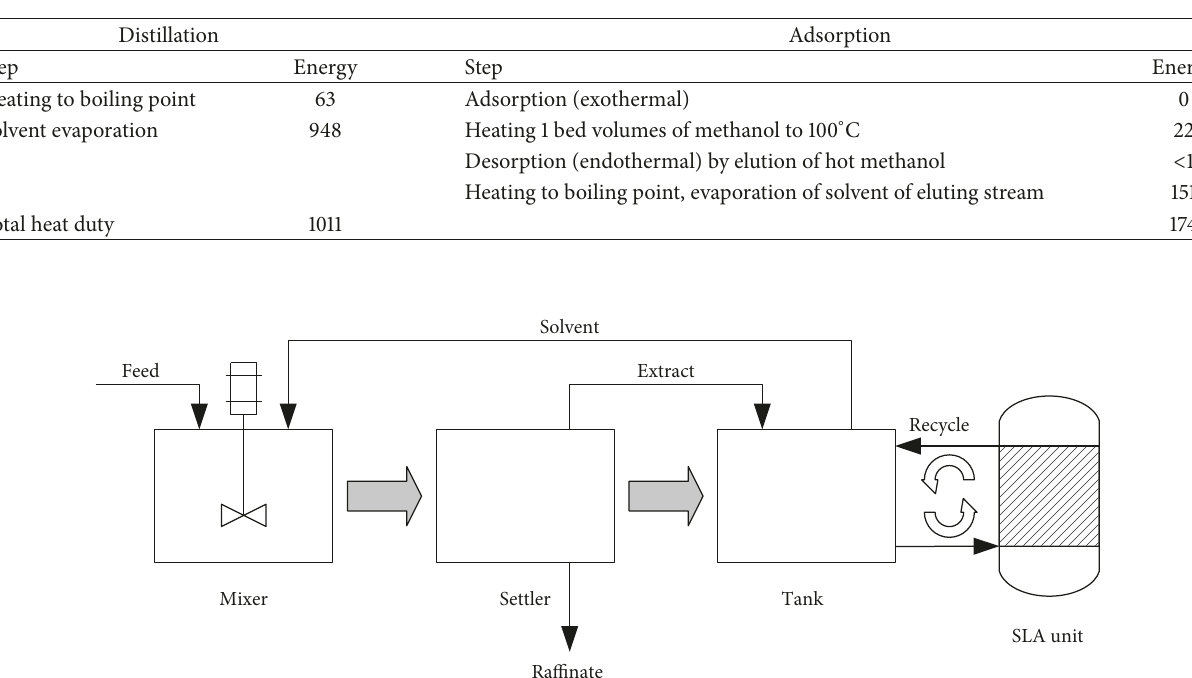
Table 4: Amounts of energy involved in the regeneration of the extract (in kJ per litre extract).